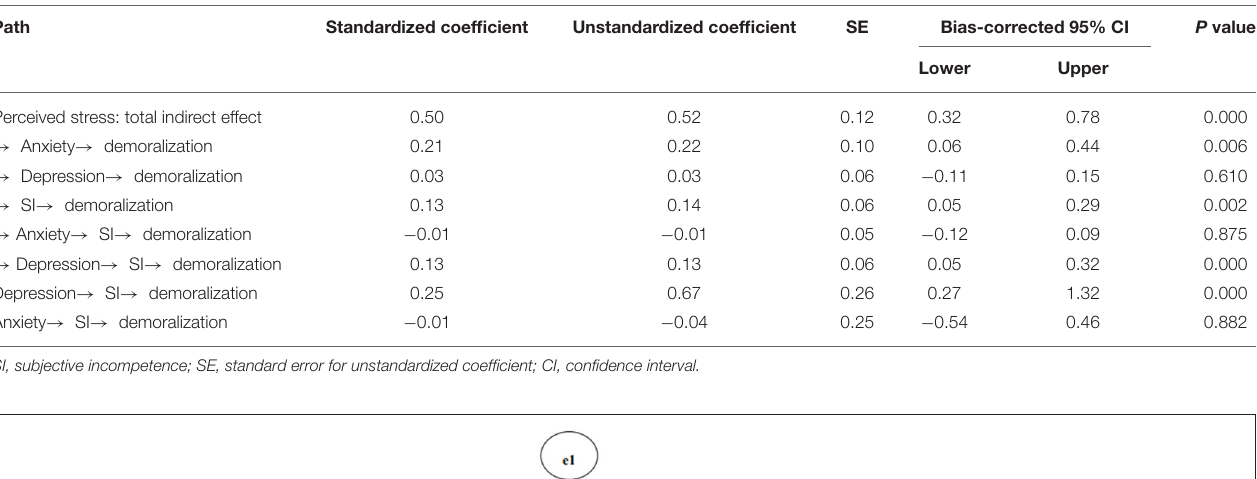
TABLE 1 | Hypotheses testing for specific indirect effects on demoralization.